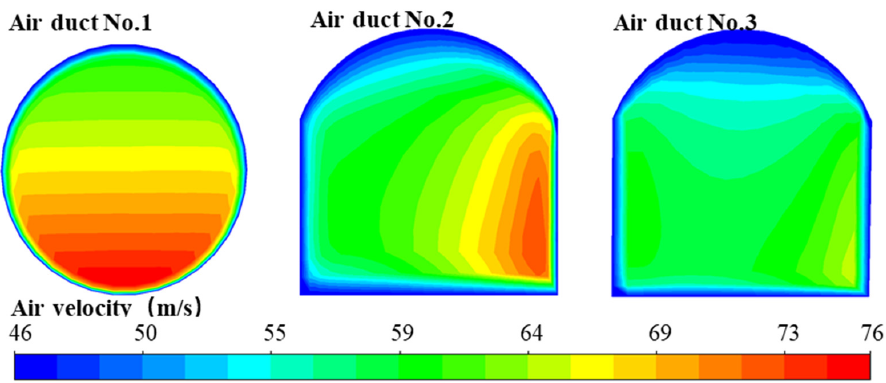
Figure 9. Air velocity distribution in the cross-section of air ducts no. 1 to no. 3 under 100% gate opening ratio.